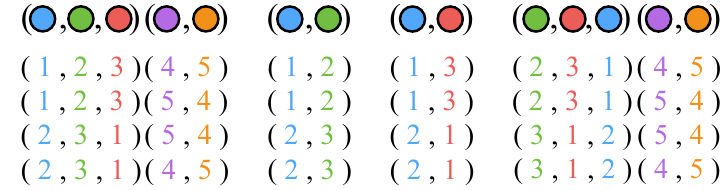
Figure 6 . Different representatives of class α 3 resentatives have the same active copies 1, 2, 3, 4, 5 appearing in different orders, preserving the relative positions of repeated